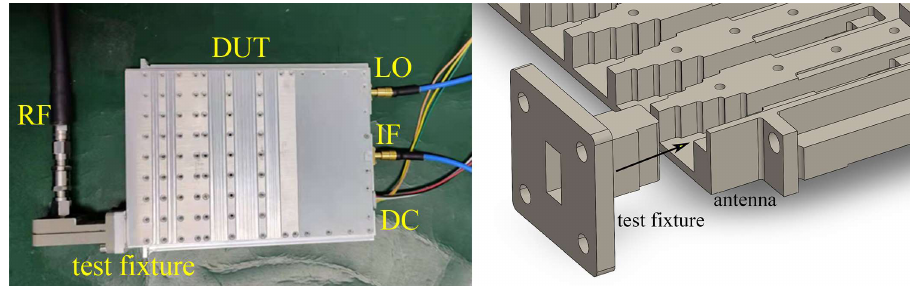
Figure 20. Diagrams of connection mode and test fixture.